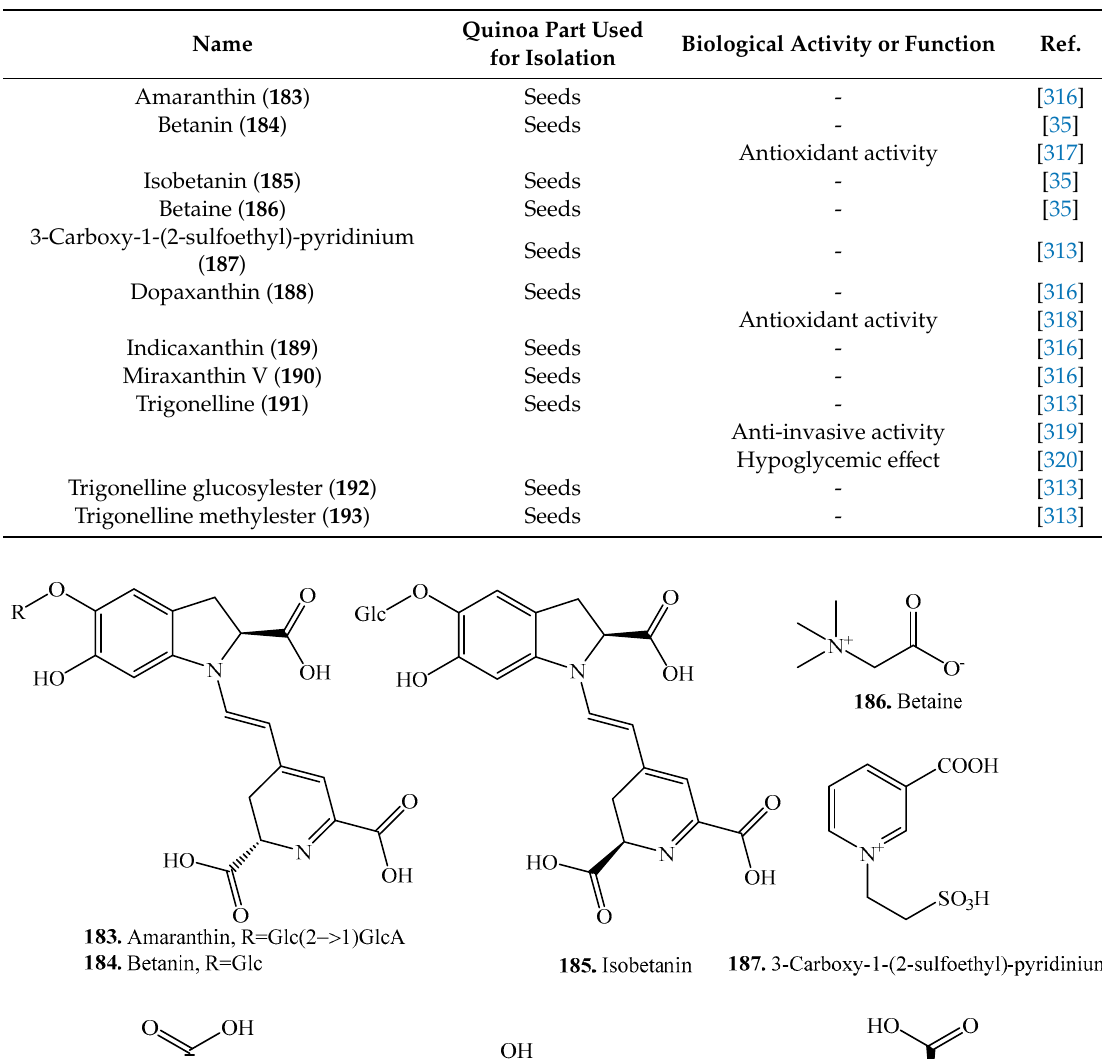
Table 22. Nitrogen-containing metabolites and their biological activities or functions.